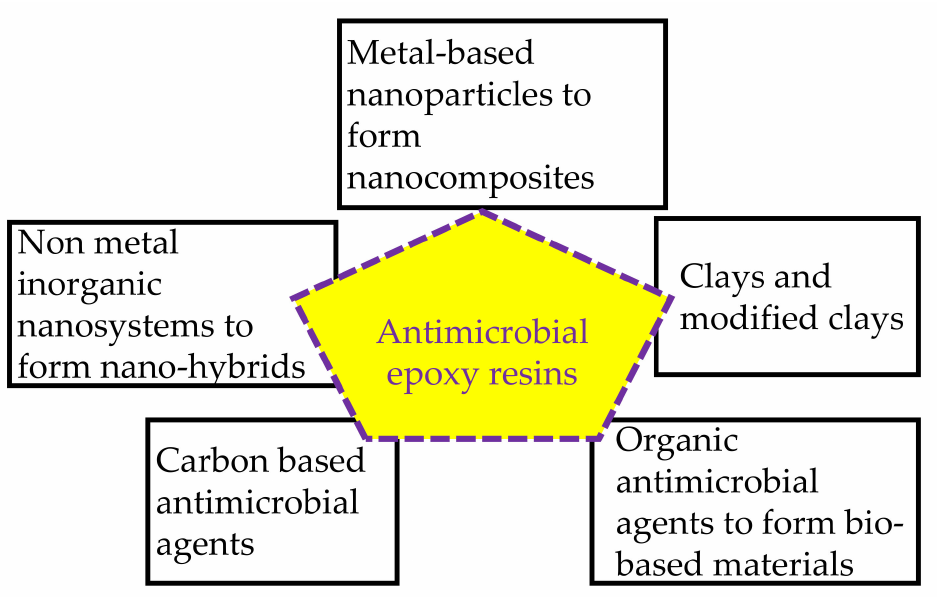
Scheme 1. Different approaches to impart antimicrobial properties to epoxy